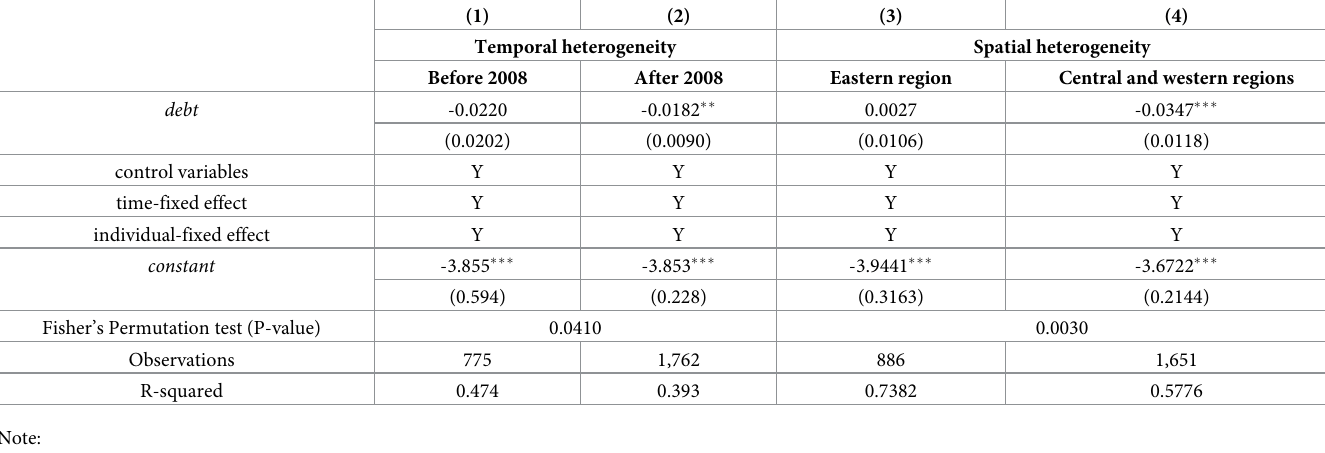
Table 6. Analysis of temporal and spatial